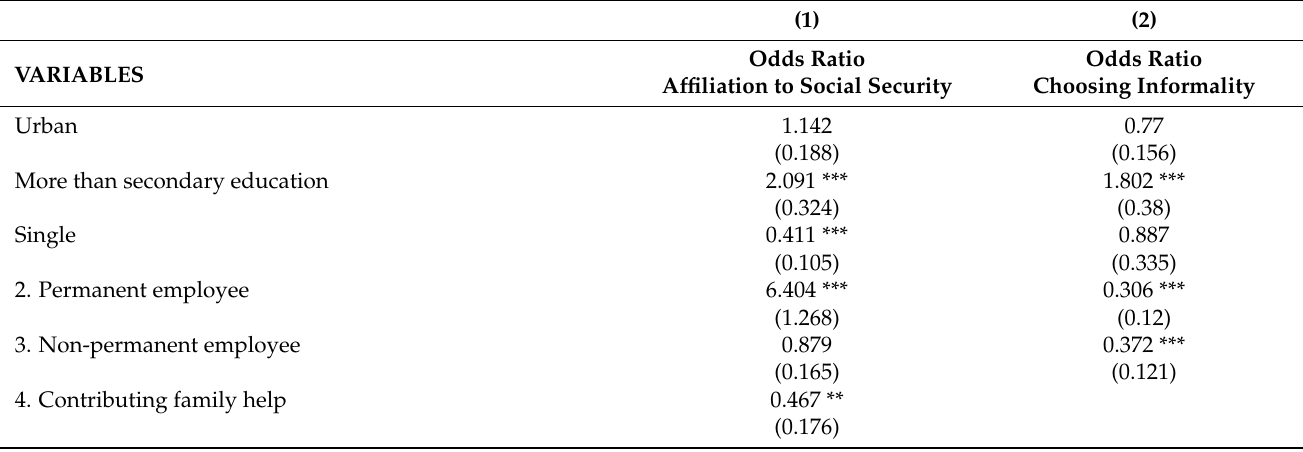
Table 2. Weighted logit model. Dependent variables: (1) affiliation to social security and (2) choosing informality. Defini- tion/description of the independent variables can be found in Appendix A. Source: Sahwa dataset using